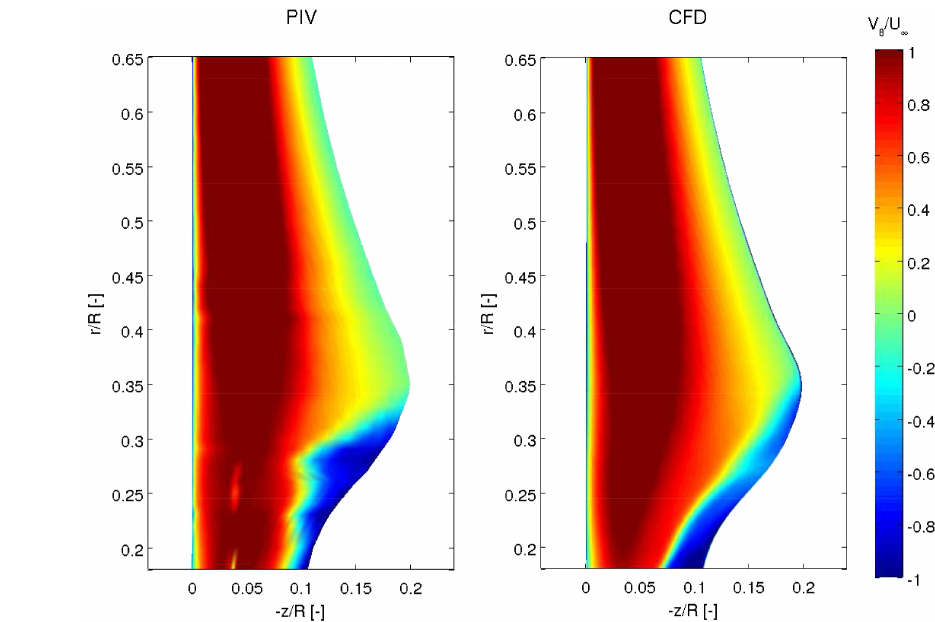
Figure 8. Experimental and numerical results of the azimuthal velocity component 10mm off the blade suction side.